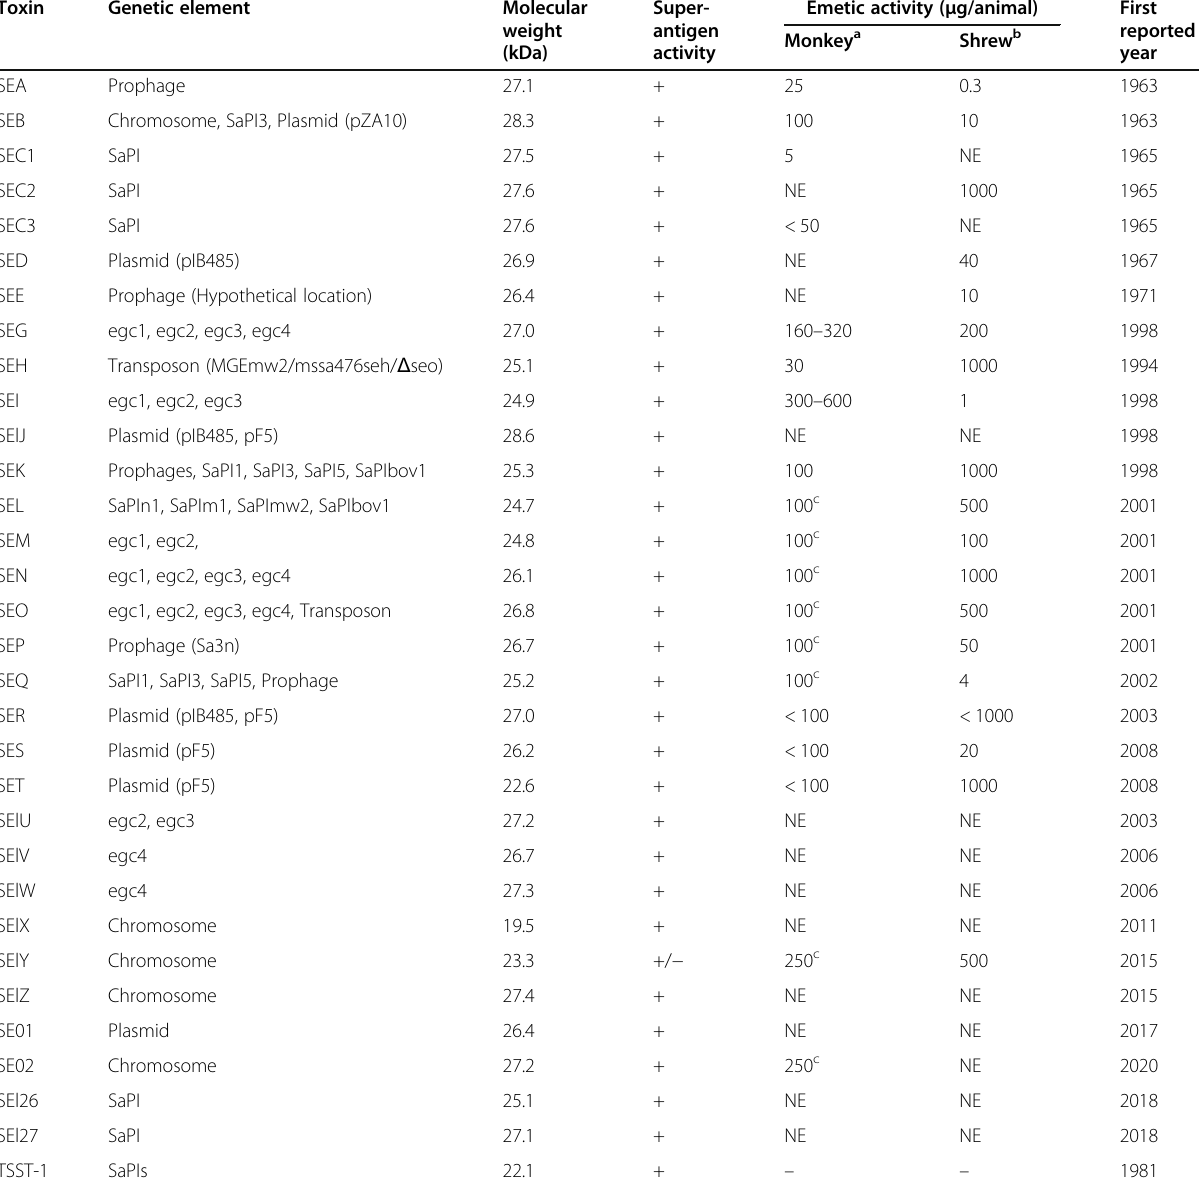
Table 1 Characteristic and pathogenicity of staphylococcal superantigen toxins Toxin Genetic element Molecular